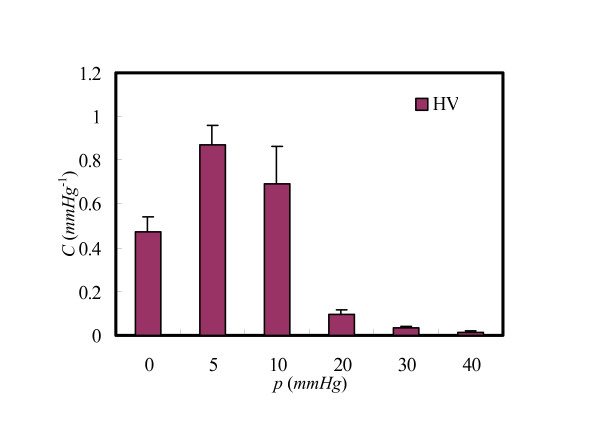
Variation of the venous compliance (HV) with pressure (λz=1.4).